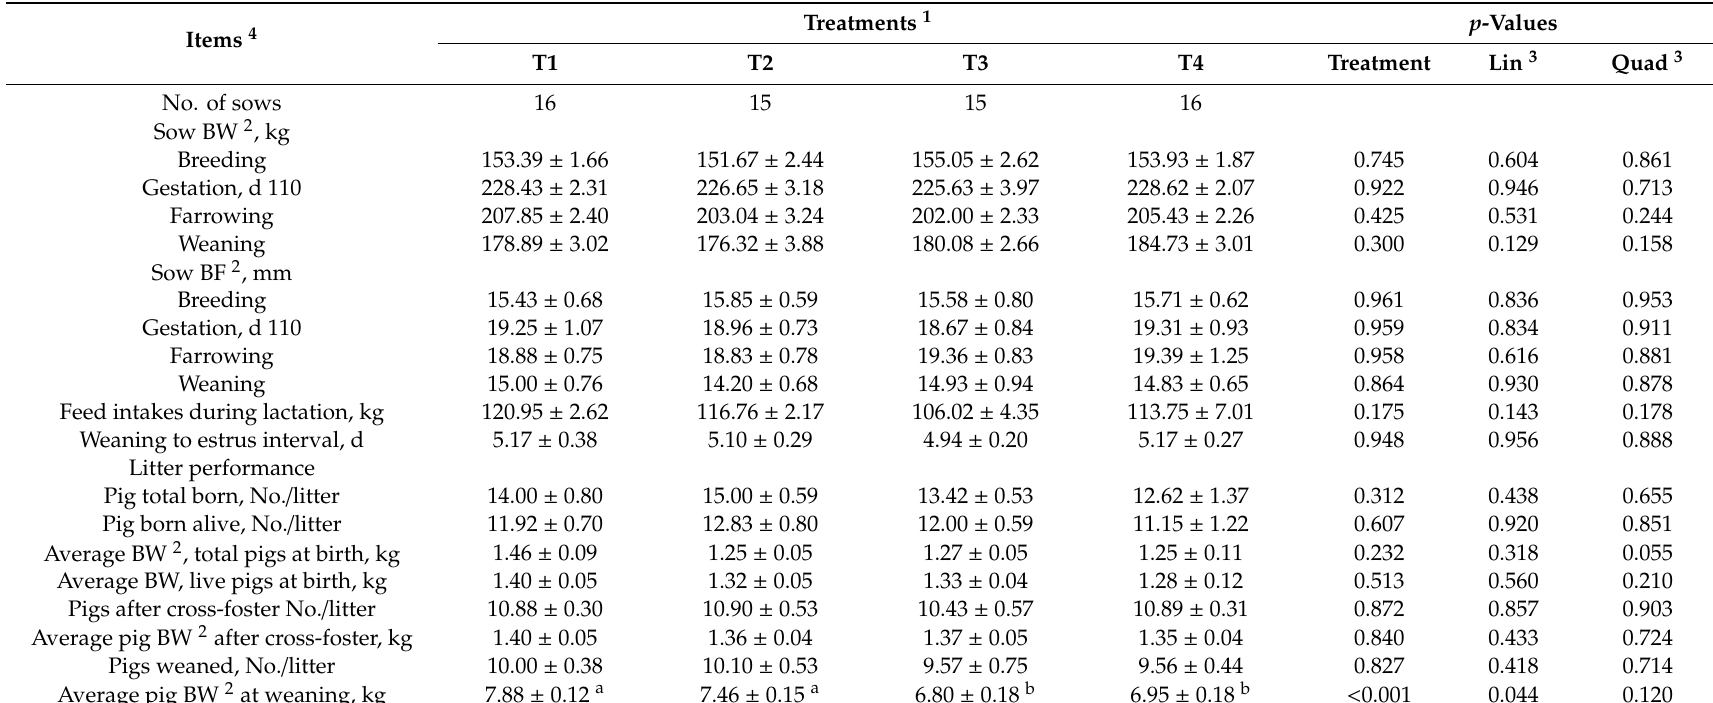
Table 3. E ff ects of the ratio of insoluble to soluble fiber in gestation diets on sow